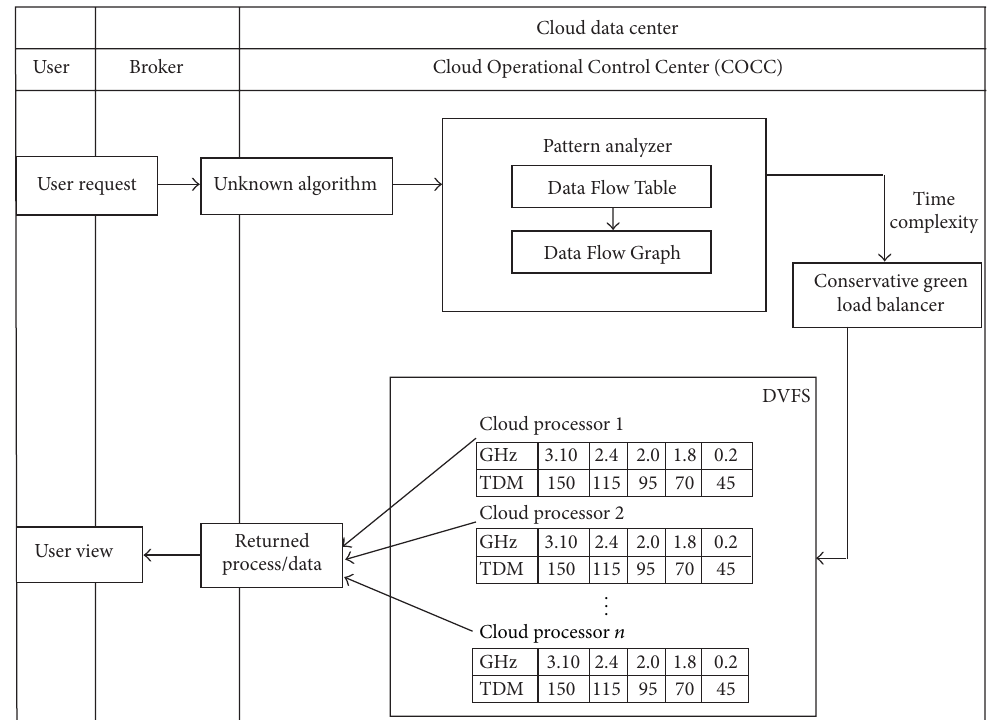
Figure 1: Architecture